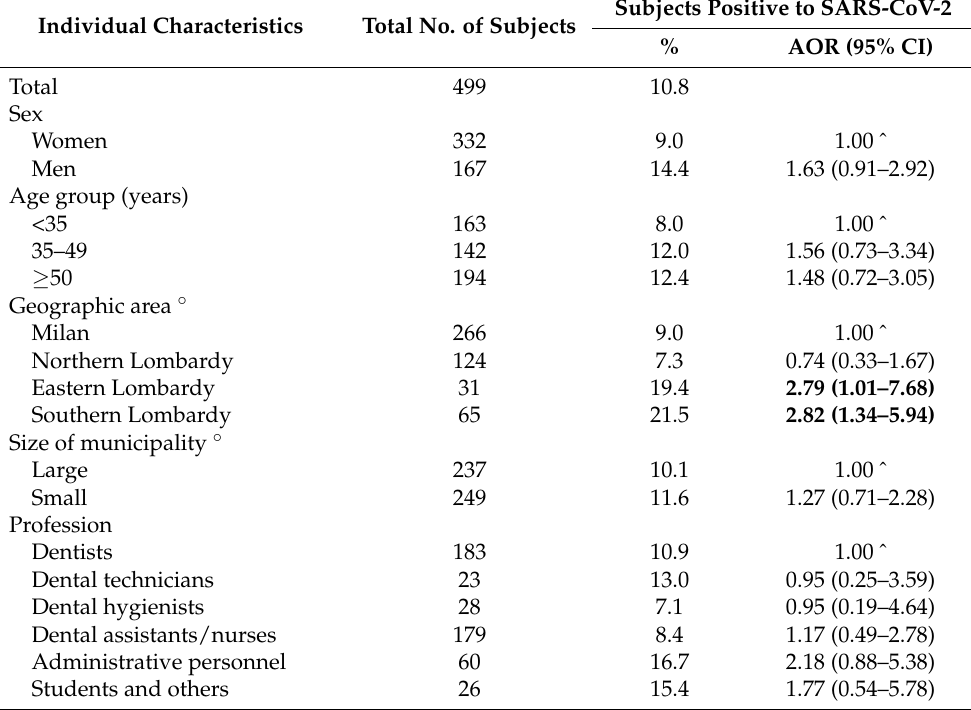
* Estimated by multiple logistic regression models after adjustment for sex and age group. Estimates in bold are those statistically significant at a 0.05 level. ˆ Reference category. ◦ The sum does not add up to the total because of a few missing